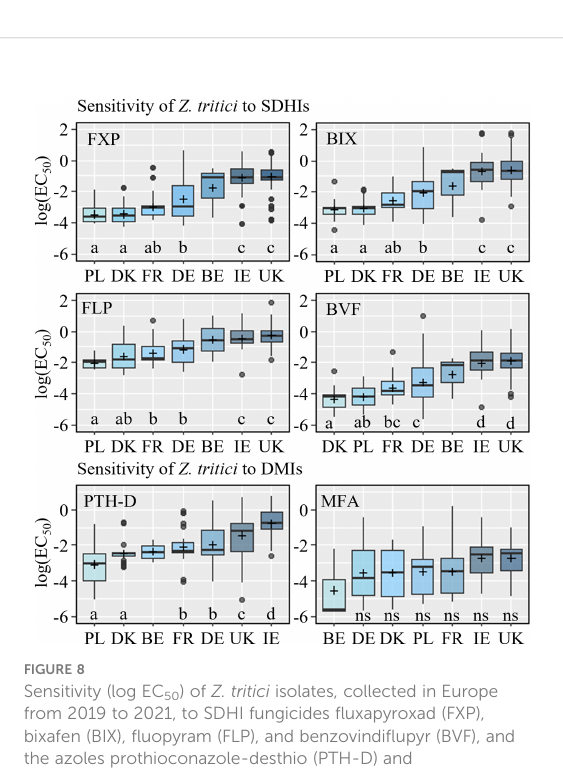
FIGURE 8 Sensitivity (log EC 50 ) of Z. tritici isolates, collected in Europe from 2019 to 2021, to SDHI fungicides fl uxapyroxad (FXP), bixafen (BIX), fl uopyram (FLP), and benzovindi fl upyr (BVF), and the azoles prothioconazole-desthio (PTH-D) and mefentri fl uconazole (MFA). Data is divided by countries Poland (PL), Denmark (DK), France (FR), Germany (DE), Belgium (BE), Ireland (IE), and the United Kingdom (UK). Different letters below the boxes represent signi fi cant differences between treatments within the plot as determined by Dunn ’ s